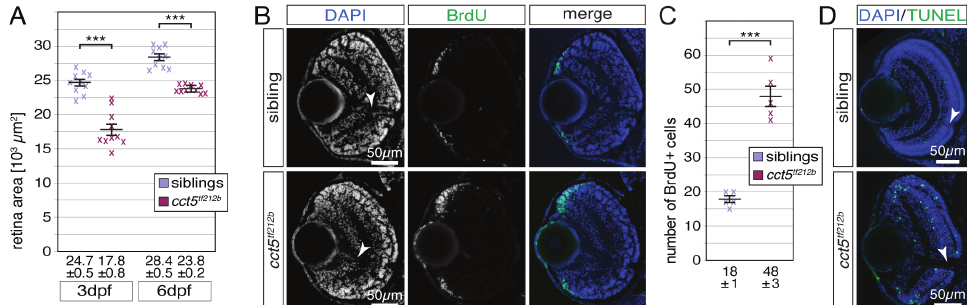
Figure 2. The retina of cct5 𝑡𝑓121𝑏 mutants is smaller and characterised by enhanced proliferation and apoptosis. (A) Quantification of the retina sizes revealed that the retinal area of cct5 𝑡𝑓121𝑏 homozygotes was significantly smaller compared to siblings. The mean retinal area of cct5 𝑡𝑓121𝑏 homozygotes was 17.8 ± 0.8 ( × 10 3 µm 2 ) at three dpf and 23.8 ± 0.2 ( × 10 3 µm 2 ) at six dpf compared to siblings that featured mean retinal areas of 24.7 ± 0.5 ( × 10 3 µm 2 ) at three dpf and 28.4 ± 0.5 ( × 10 3 µm 2 ) at six dpf; n = 10 per genotype and stage. (B) In contrast to three-dpf-old siblings, more BrdU-positive cells (green) were detected at the periphery of the retina within the ciliary marginal zone of cct5 𝑡𝑓121𝑏 homozygotes. (C) Quantification of the number of BrdU-positive cells within individual retinas revealed that significantly more cells were proliferating within the ciliary marginal zone of cct5 𝑡𝑓121𝑏 homozygotes at three dpf. Whereas cct5 𝑡𝑓121𝑏 had 48 ± 3 BrdU-positive cells per retinal cross section, 18 ± 1 were proliferating in siblings ( n = 5). (D) In contrast to the retina of three-dpf-old siblings, in which apoptotic cells were rarely labelled by the TUNEL assay (green), apoptosis was frequently observed throughout the entire retina of cct5 𝑡𝑓121𝑏 homozygotes. Data are mean ± SEM; *** P < 0.001 by Student’s t -test. Arrowheads indicate optic nerves